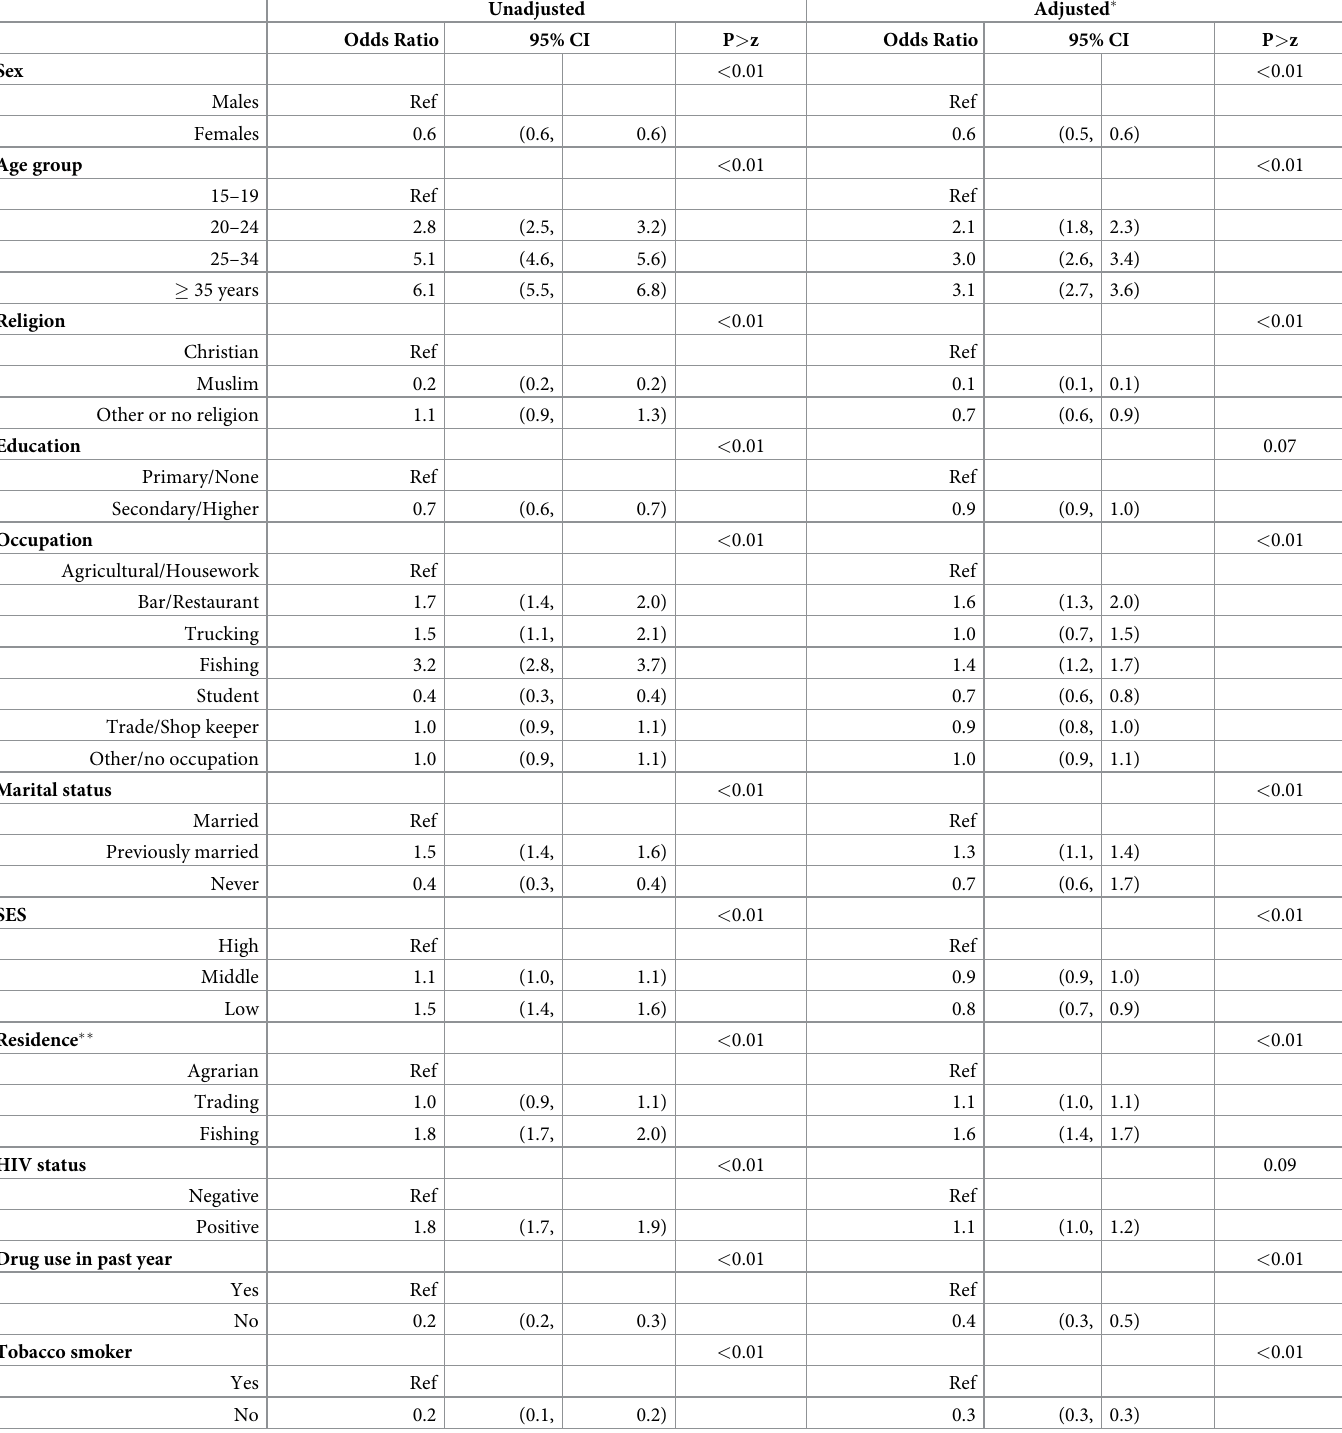
Table 2. Unadjusted and adjusted logistic regression models of correlates of alcohol use in the past 12 months in all men and women (N = 18,700) who participated in RCCS between March 2015 and September 2016. Unadjusted Adjusted � Odds Ratio 95% CI P > z Odds Ratio 95% CI P > z <